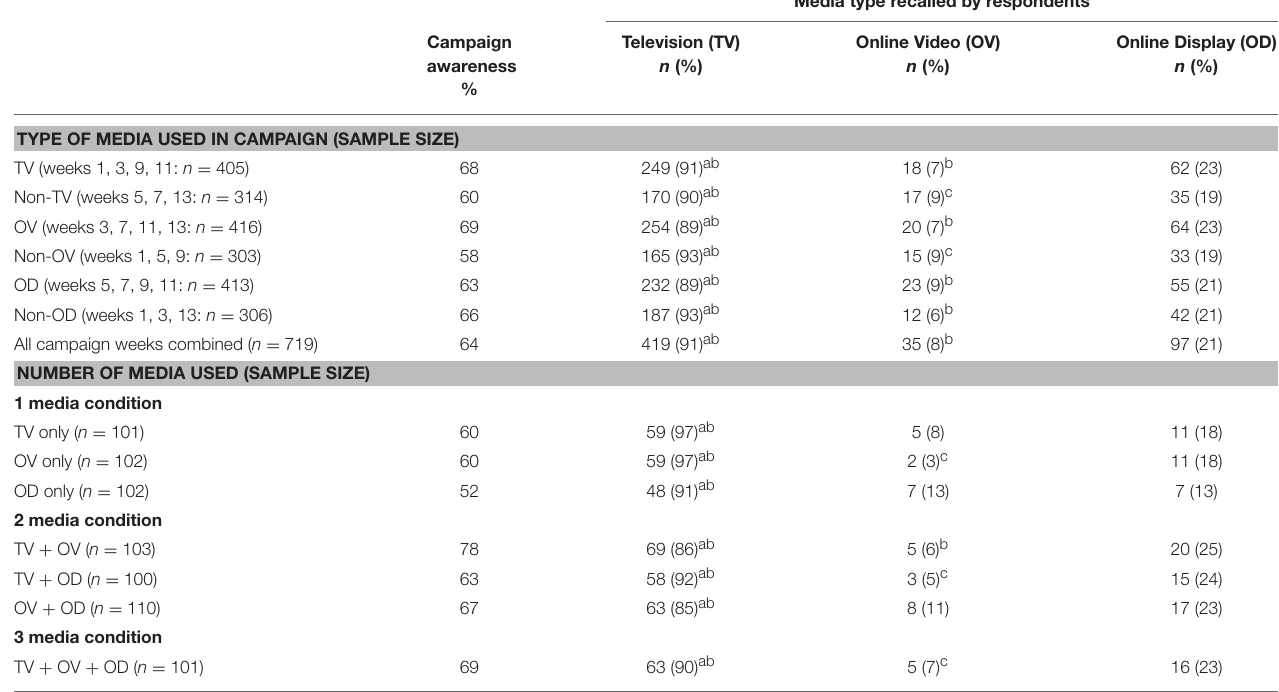
TABLE 2 | Media used vs. respondents ′ reported media exposure.